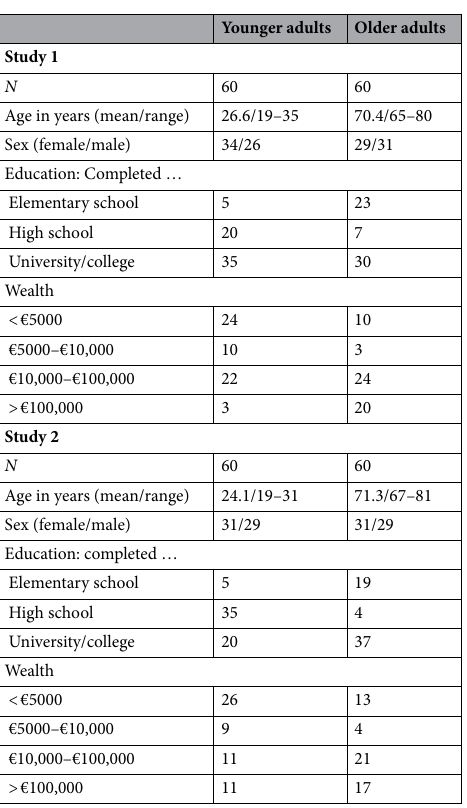
Table 1. Sociodemographic characteristics of participants in studies 1 and 2. Wealth = estimated overall current assets minus overall debts in € (95% of participants provided information about